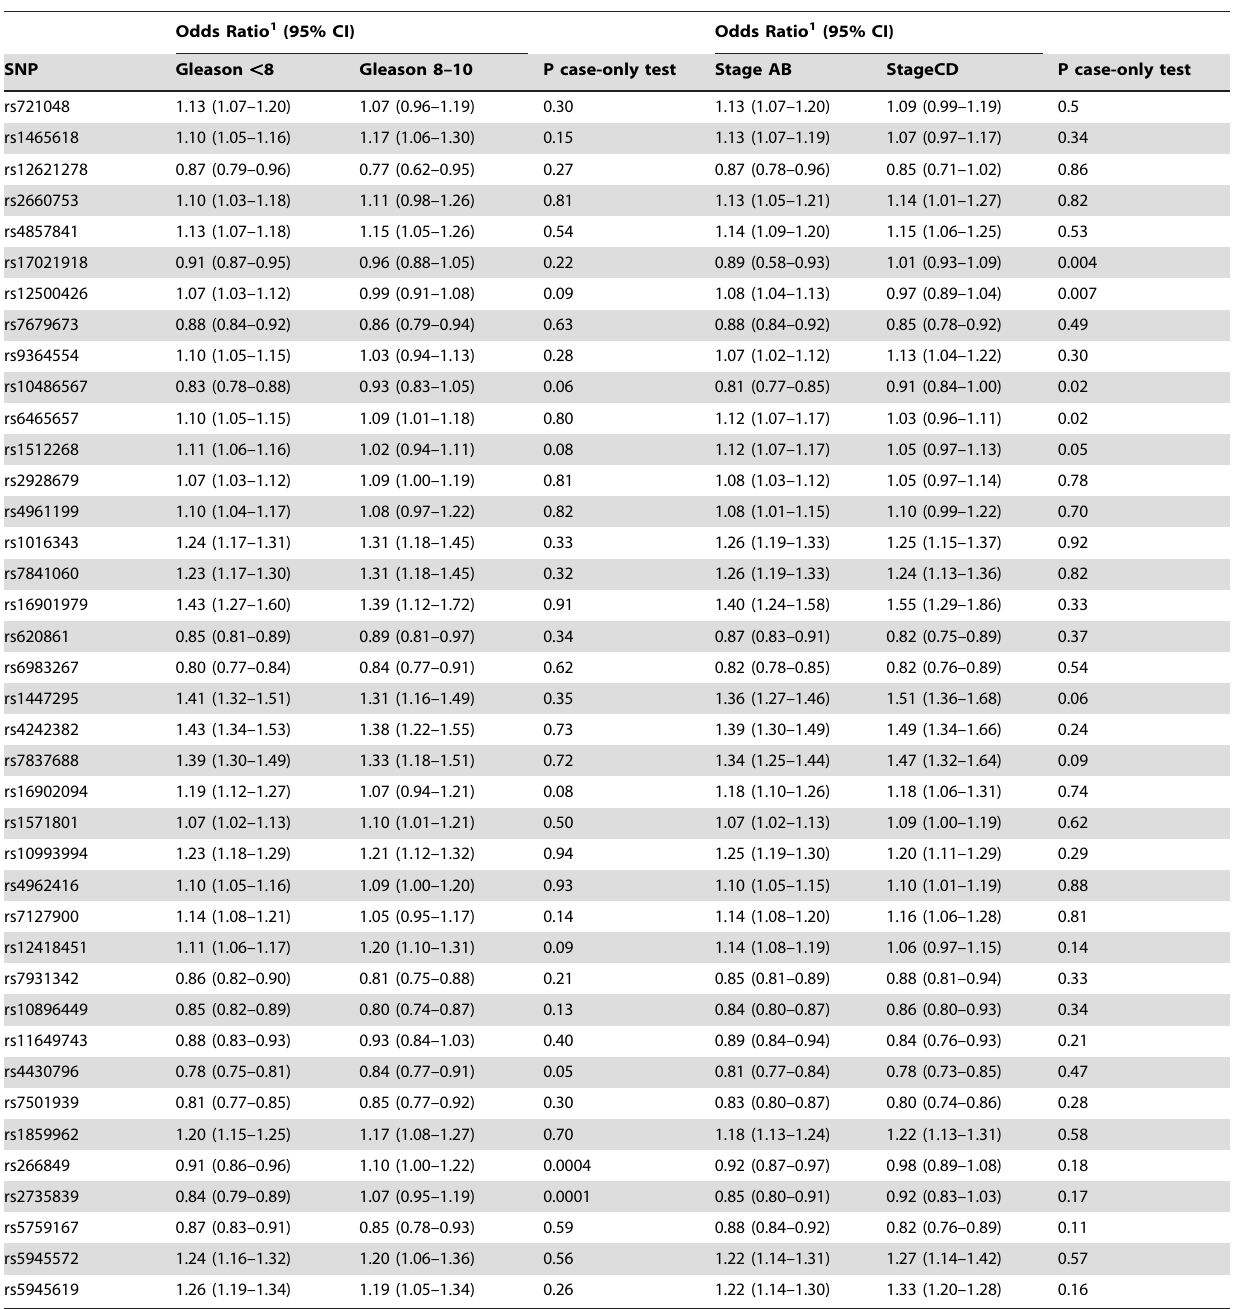
Table 3. Associations between selected SNPs and Gleason grade and